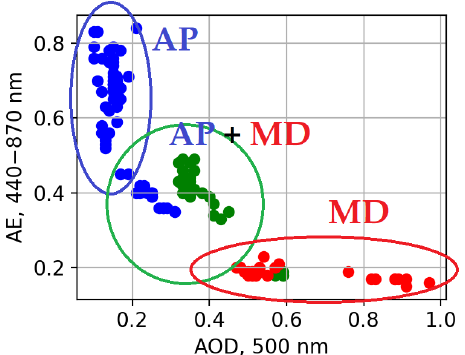
Figure 7. Scatter plot for aerosol optical depth (500 nm) versus Ångström exponent (440–870 nm) dependency during 23–25 April 2019: blue dots—23 April, green—24 April, and red—25 April. AP—anthropogenic aerosol particles; MD—mineral dust. Data level